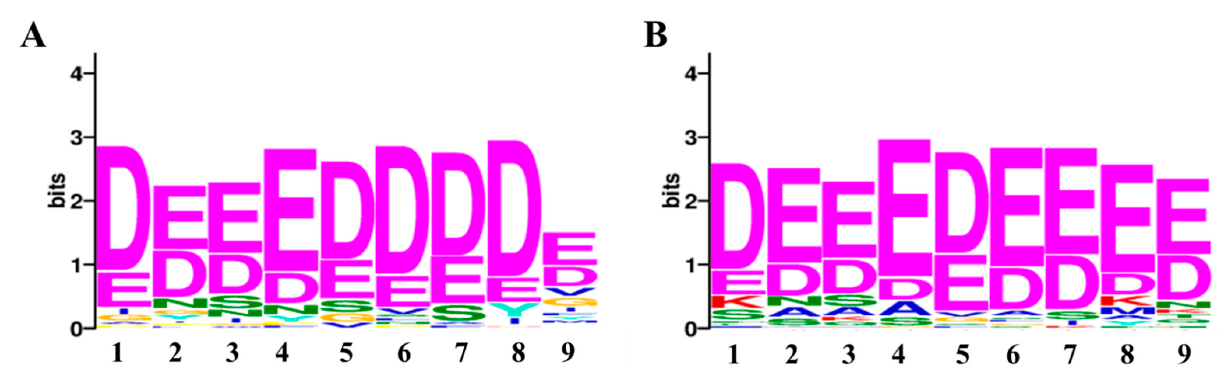
Figure 11. The significantly enriched motif in the yeast protein targets of penetratin ( A ), and Sub-5 ( B ). Using STREME tool, the enriched consensus motif is identified in the protein targets of penetratin and Sub-5. The number of protein targets containing the enriched motif was 46.3% (i.e., 57 proteins) for Penetratin with a p -value of 0.031 and 50% (i.e., 64 proteins) for Sub-5 with a p -value of 0.019. No significant enriched motif was identified in the protein targets of LfcinB or Histatin-5.